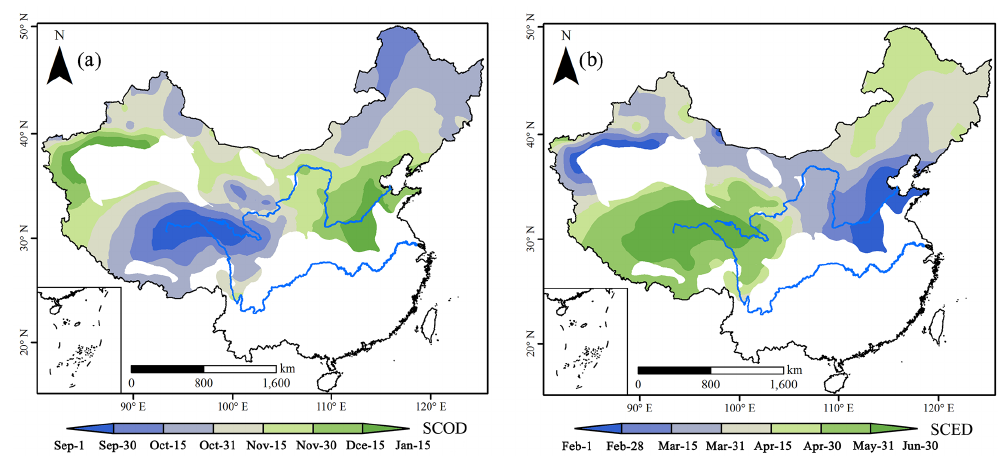
Figure 8. Spatial distribution of SCOD (a) and SCED (b) based on the stations with an average of more than 10